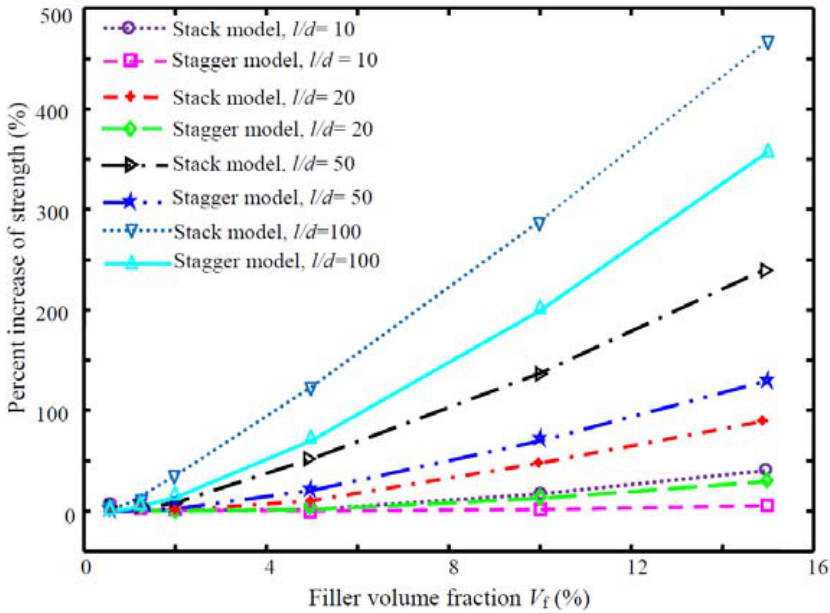
Figure 17. Variation of the percent increase of tensile strength (compared to matrix) with the filler volume fraction V f for different clay-particle aspect ratios ρ = 10, 20, 50 and 100.